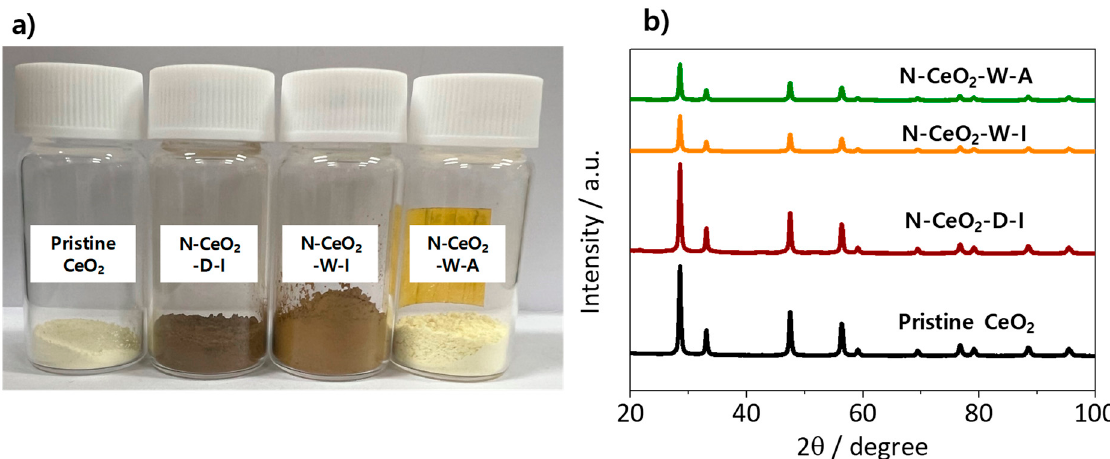
Figure 5. ( a ) Photographs of the pristine CeO 2 and the N-doped CeO 2 NPs. ( b ) XRD spectra of the pristine CeO 2 and the N-doped CeO 2 prepared by various methods.